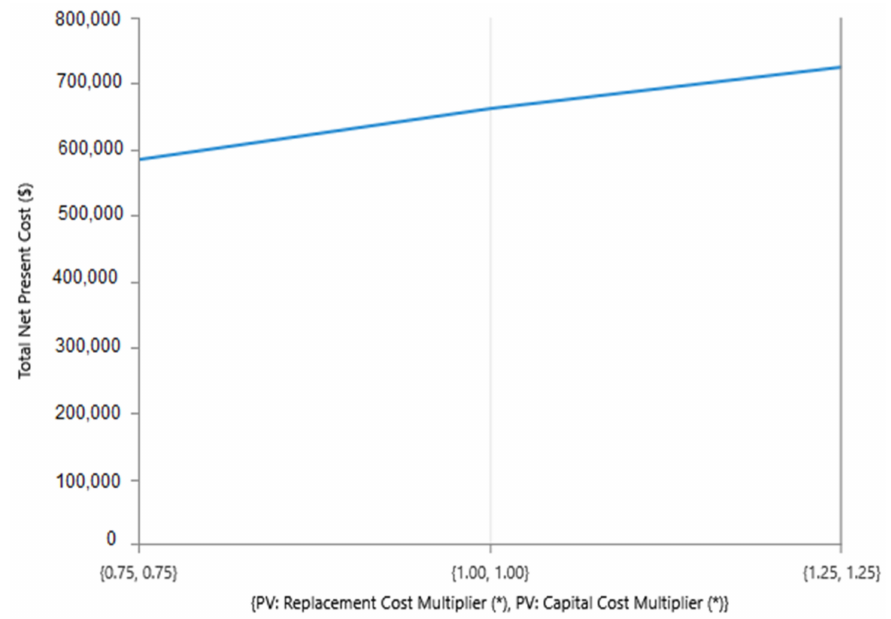
Figure 15. Effect of PV system Cost on TNPC of the proposed system.